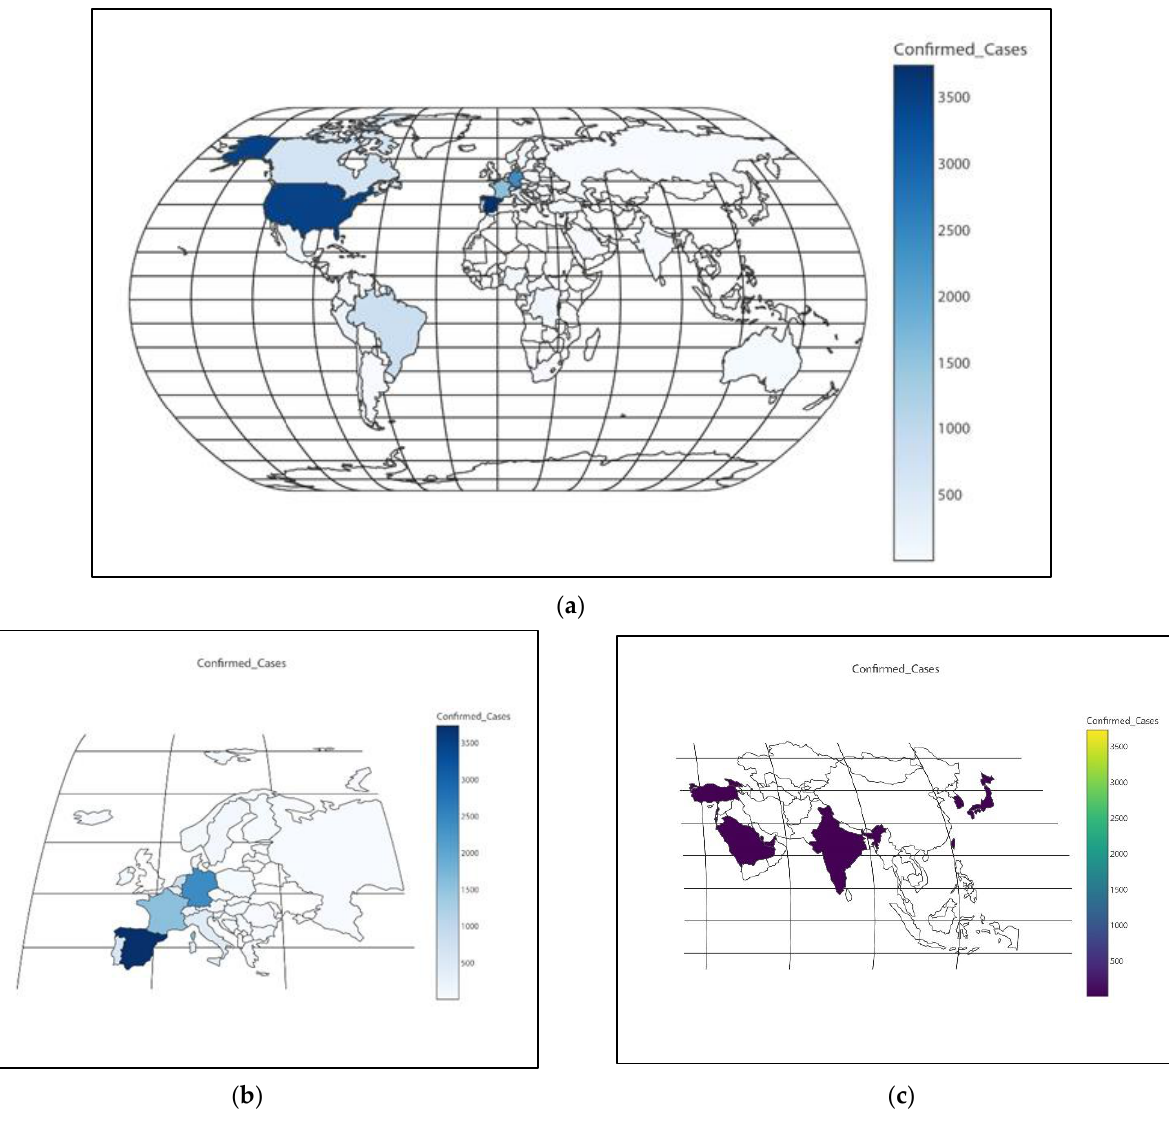
Figure 3. ( a ) Worldwide distribution of confirmed cases; ( b ) European distribution of confirmed cases; ( c ) Asian distribution of confirmed cases.